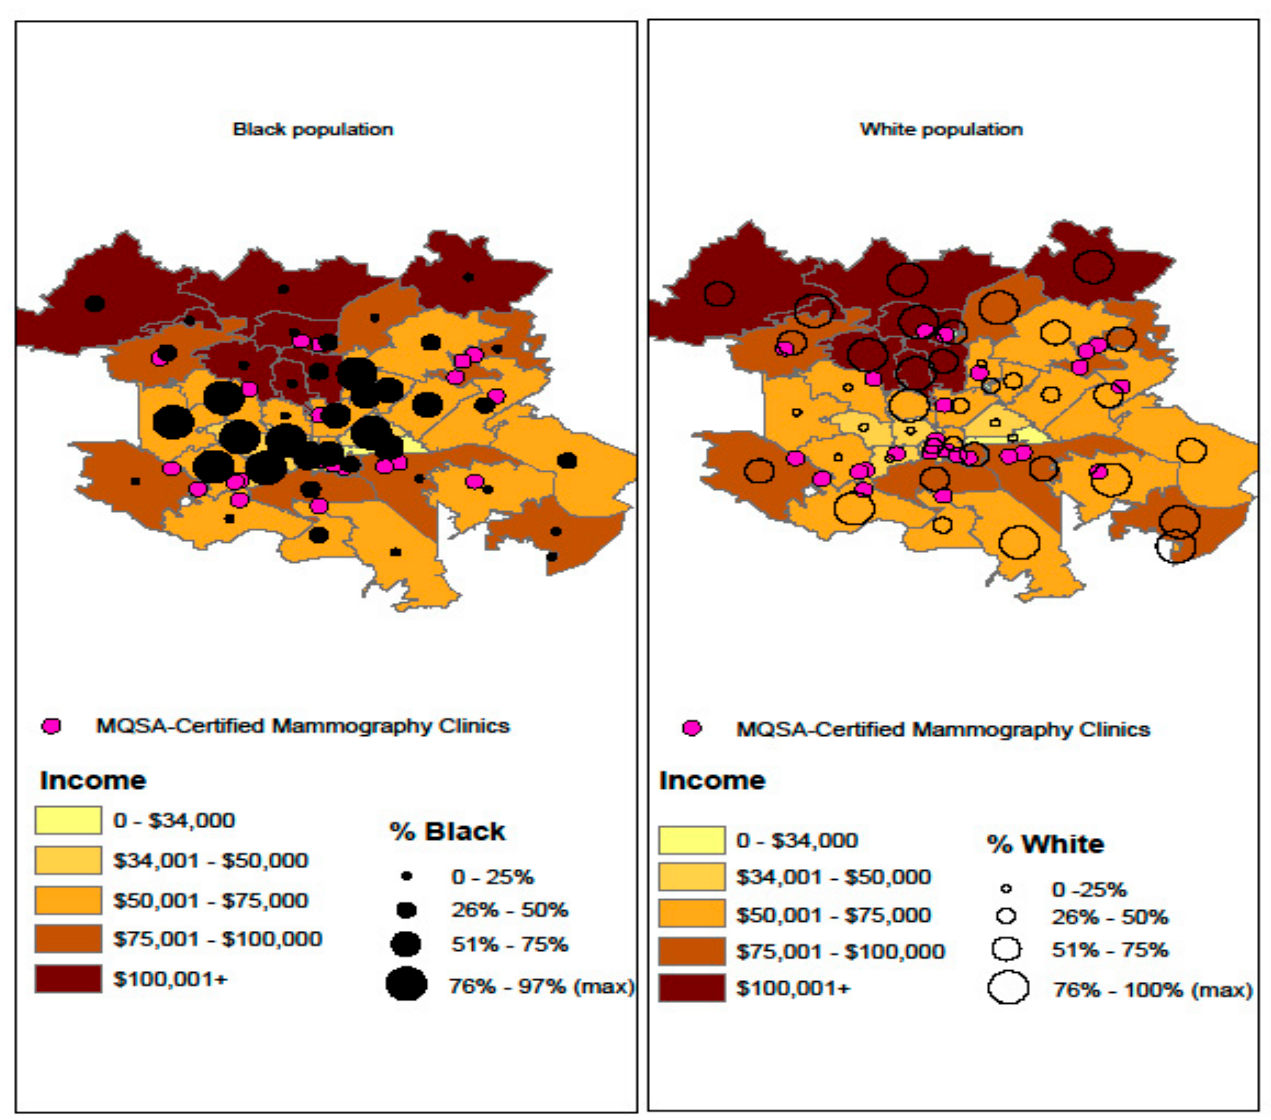
Figure A8. Percent Black vs. Percent White Population, MQSA-Certified Mammography Clinics, and Income by ZIP Code Tabulation Area in Baltimore, MD.